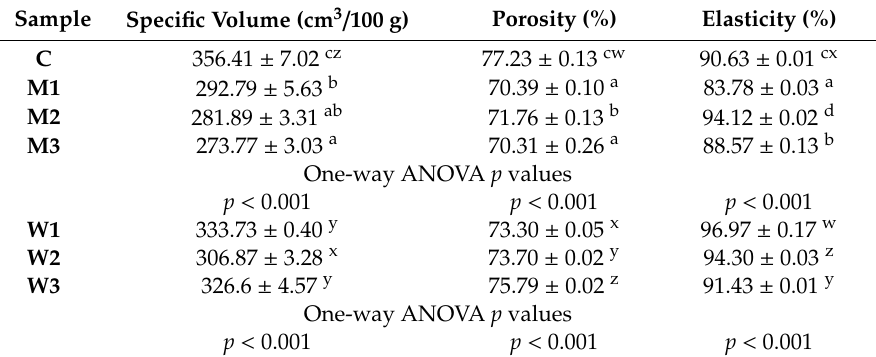
Table 3. Physical properties of bread with di ff erent water replacement levels.